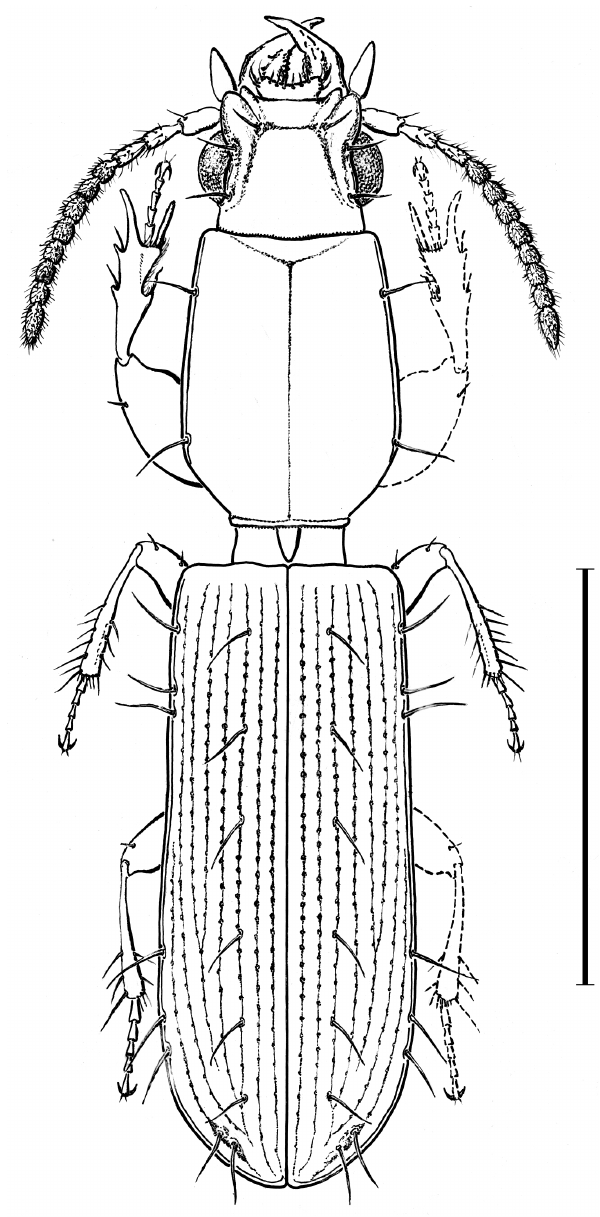
Figure 1. Habitus of Torretassoa alfierii Schatzm. & Koch from Iraq. Scale bar 1 mm.